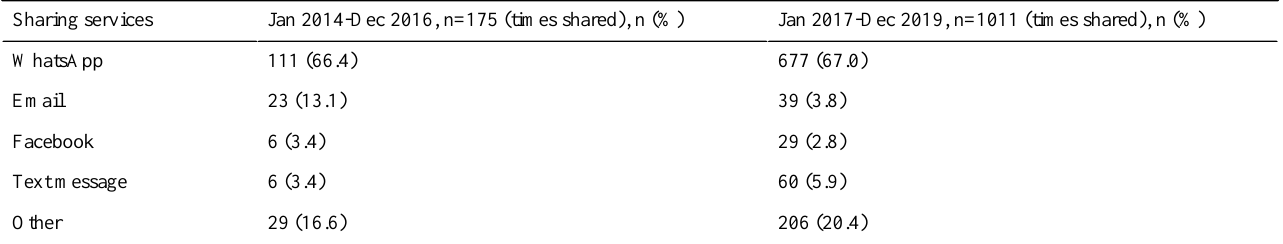
Table 3. Sharing